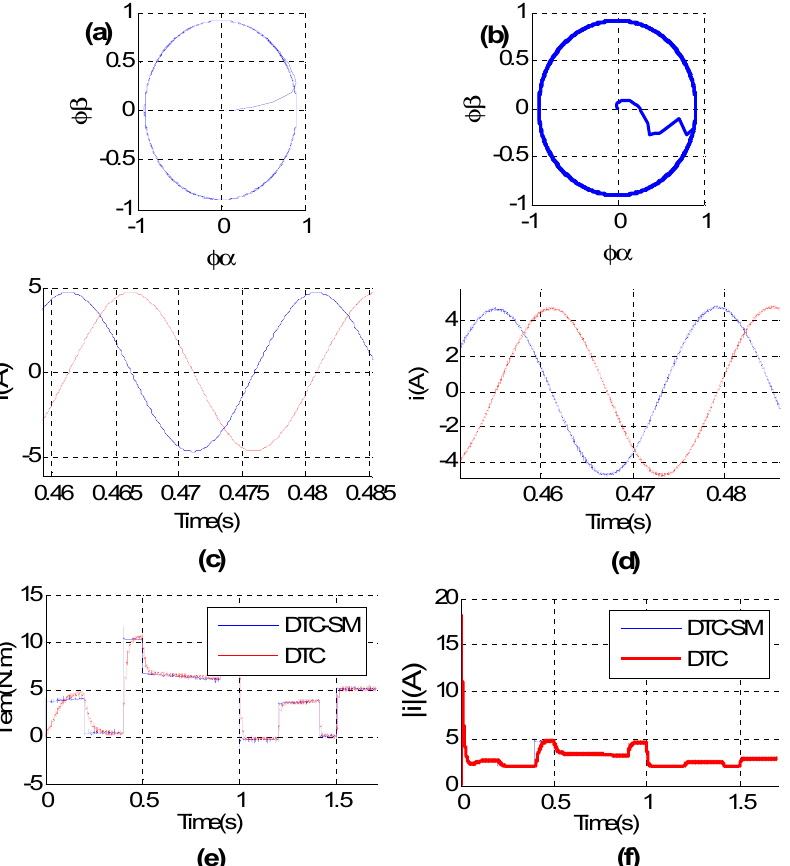
Figure 9. Simulation results of IM performance when controlled with DTC and DTC − SM techniques: ( a ) flux trajectory under DTC strategy; ( b ) flux trajectory under DTC − SM strategy; ( c ) magnified view of the stator current under DTC strategy; ( d ) magnified view of the stator with DTC − SM tech- nique; ( e ) torque responses under DTC and DTC − SM strategies; ( f ) stator current magnitude under both strategies.